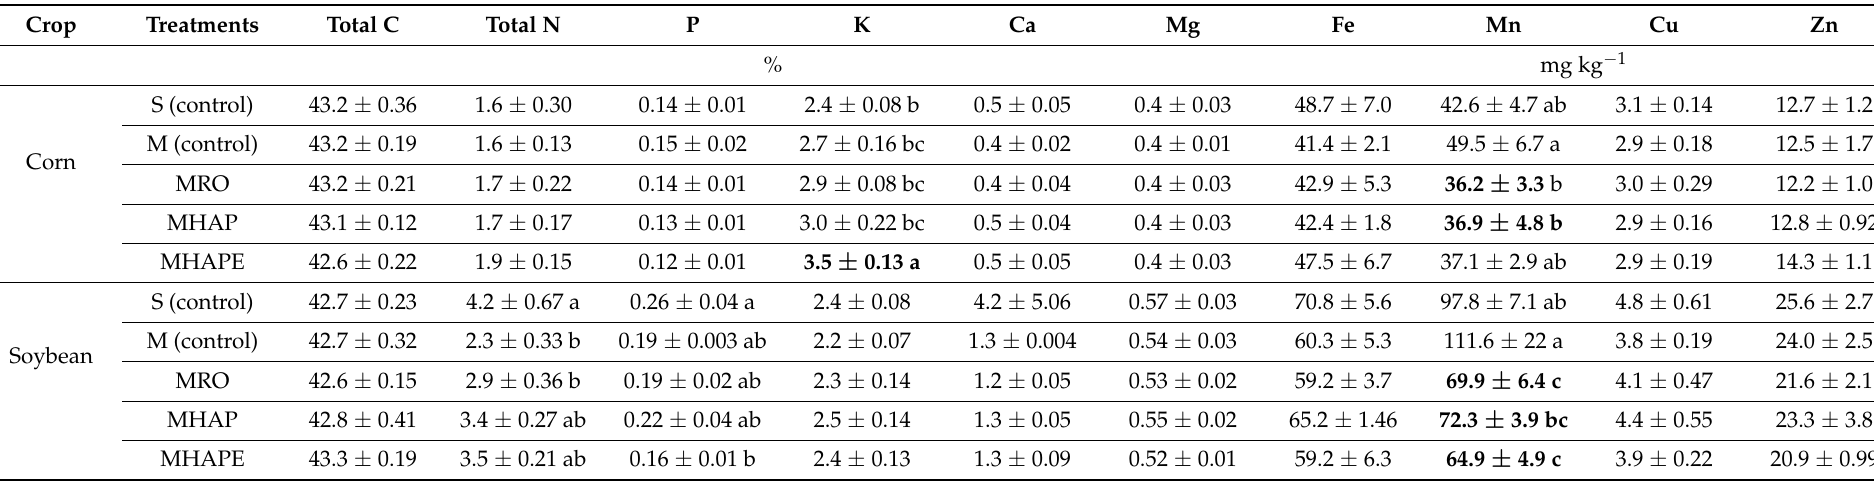
Note: Here, the letters corresponding to the values should be read as a > b > c >